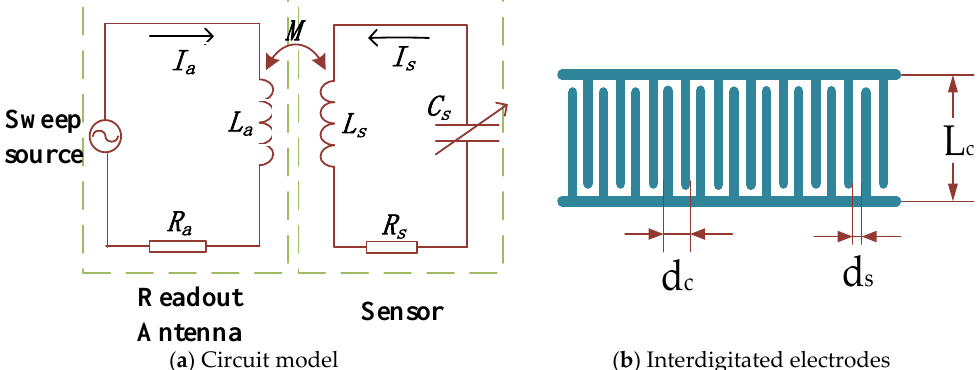
Figure 1. Schematic circuit model and interdigitated electrodes: ( a ) The circuit consists of a capacitor, an inductor and series resistance, where R a and L a respectively represent the equivalent resistance and equivalent inductance of the readout antenna; L s , R s and C s respectively represent the inductance, resistance and sensitive capacitance of the sensor circuit loop; and M represents the mutual inductance coupling coefficient between L a and L s . ( b ) L c is the length between the interdigitated electrodes; d c is the total spacing between two adjacent fingers; d s is the distance between two adjacent interdigitated fingers that are not covered by metal conductor; and N c is the number of interdigital pairs.